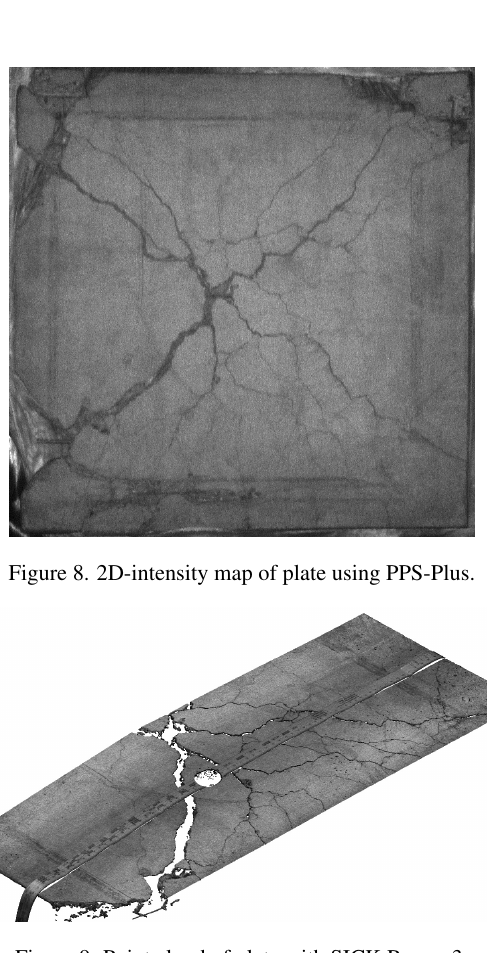
Figure 9. Point cloud of plate with SICK